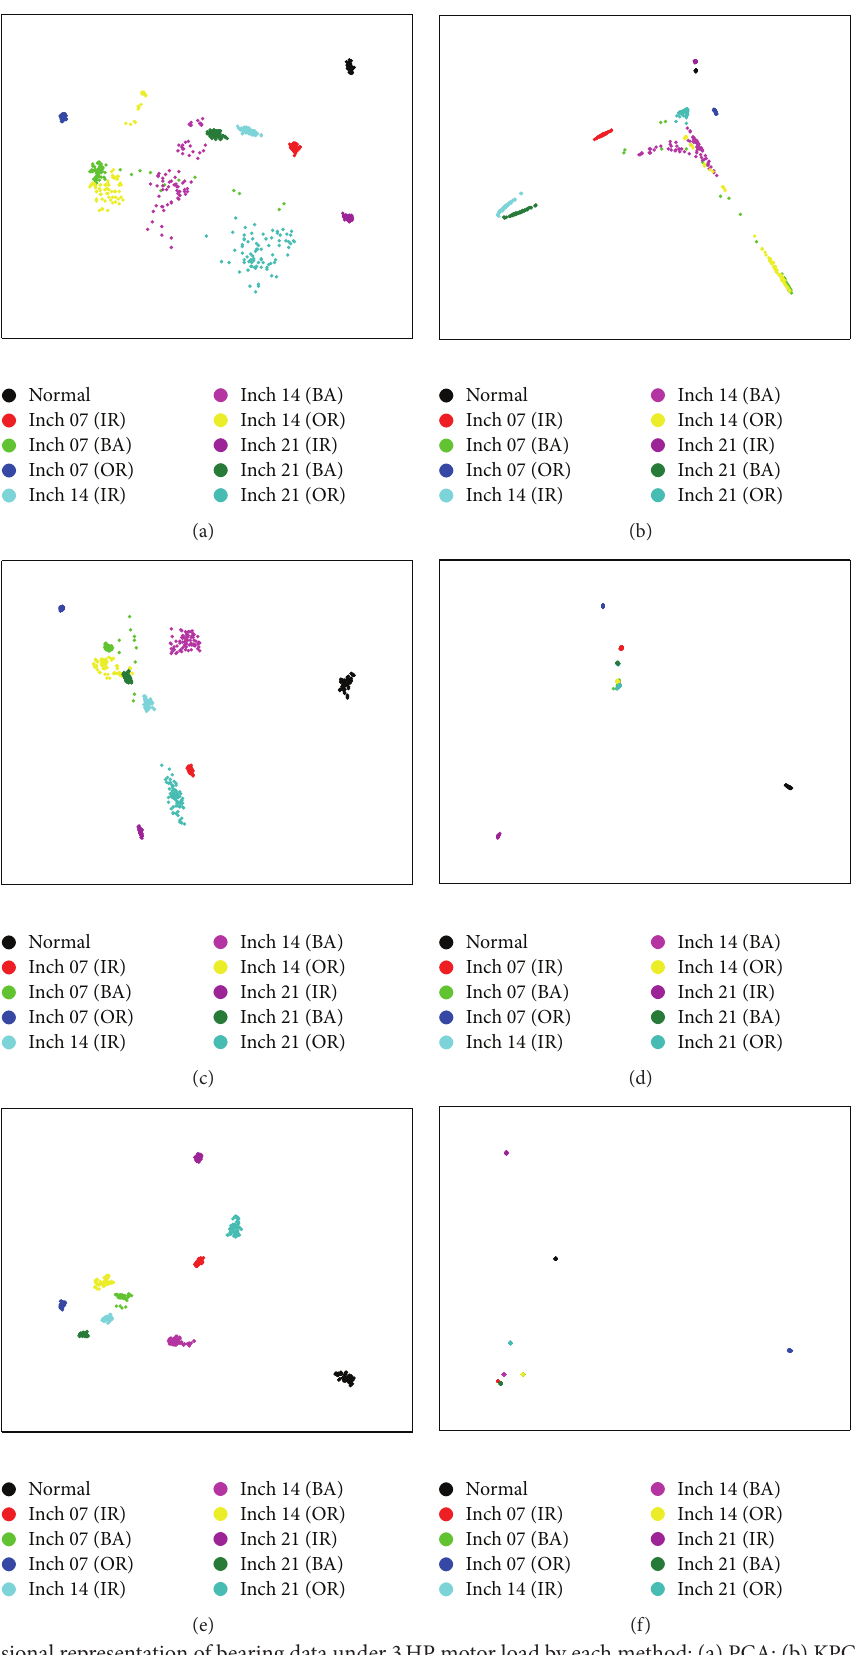
Figure 4: Two-dimensional representation of bearing data under 3 HP motor load by each method: (a) PCA; (b) KPCA; (c) LDA; (d) KDA; (e) TR-LDA; (f)